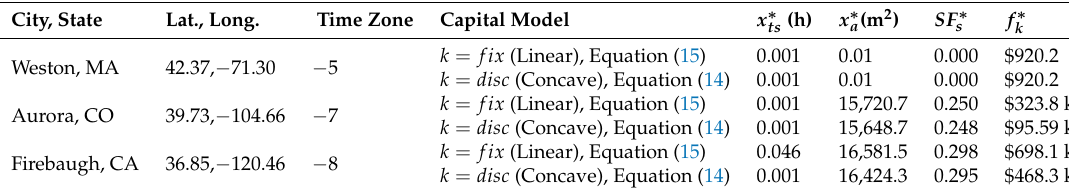
Table 3. The optimal solar-IPH hybridization strategies for the three geographic locations for constant IPH demand with ¯ q p = 10 5 kW for the industrial fuel rate. The global optimal results for the concave capital cost model in Equation (14) are included for comparison against the linear capital cost model in Equation